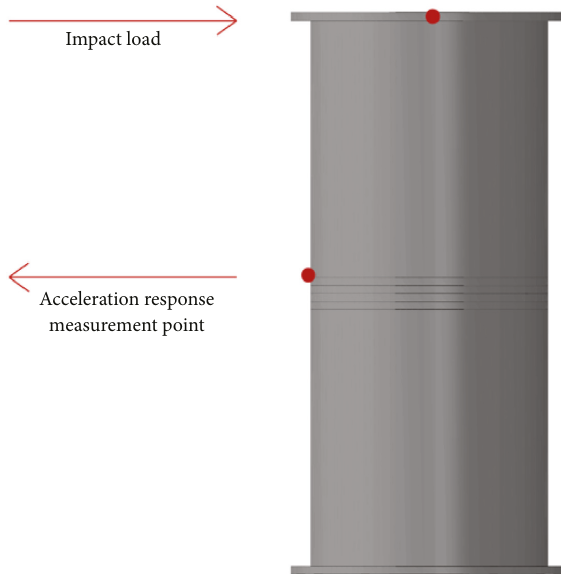
Figure 10: Schematic diagram of the calculation